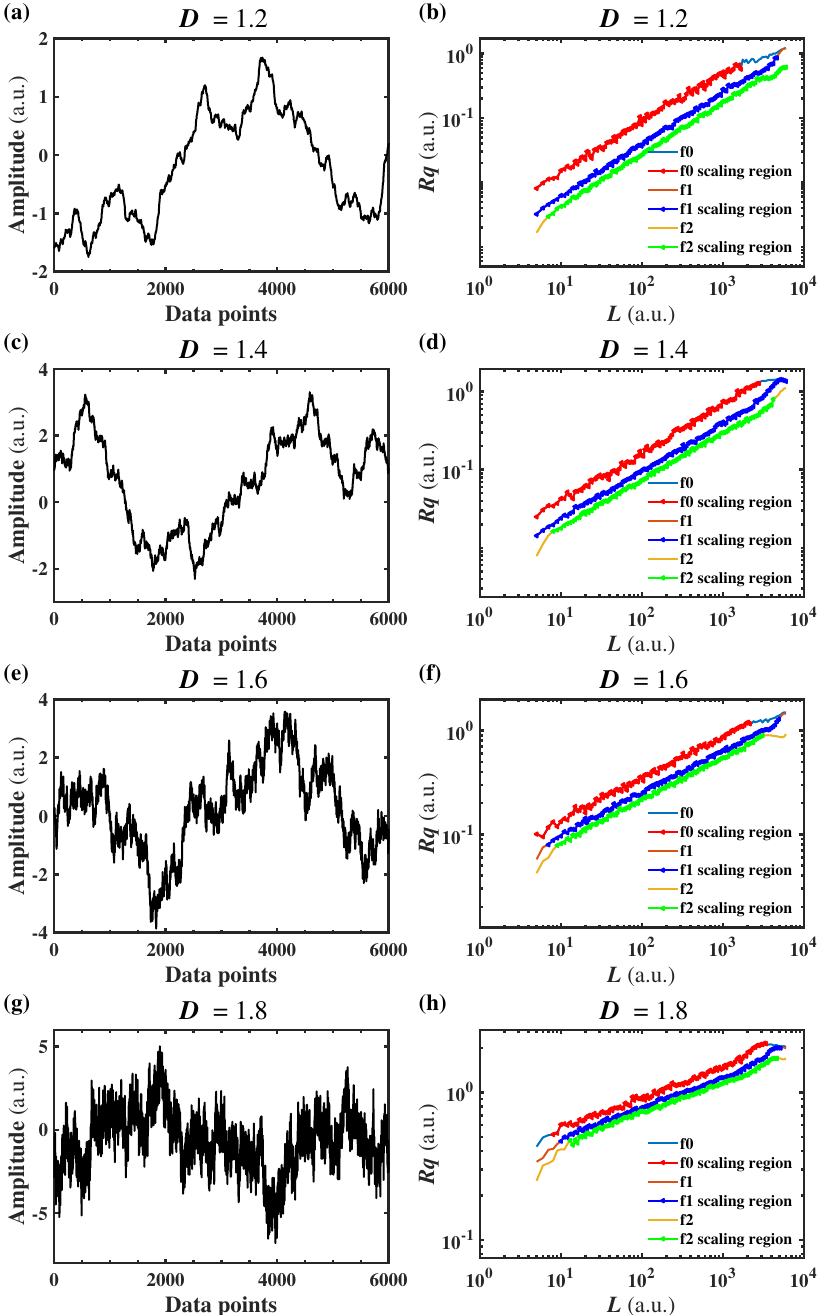
Figure 6. At the same sequence length 6000, different fractal dimensions of the original curve and the performance of the scaling region interception method under 0, 1, and 2 order flattening pre-processing conditions. ( a , b ) D = 1.2; ( c , d ) D = 1.4; ( e , f ) D = 1.6; ( g , h ) D =